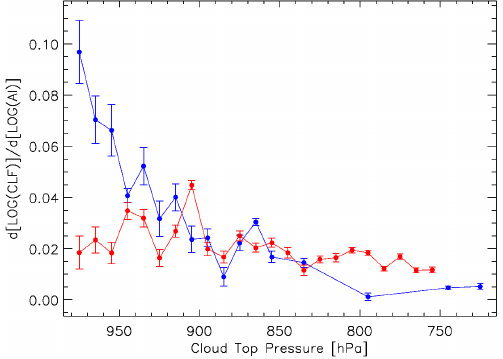
Fig. 12. Liquid Water Path (LWP) retrievals averaged over constant bin of Cloud Optical Thickness (COT). Input